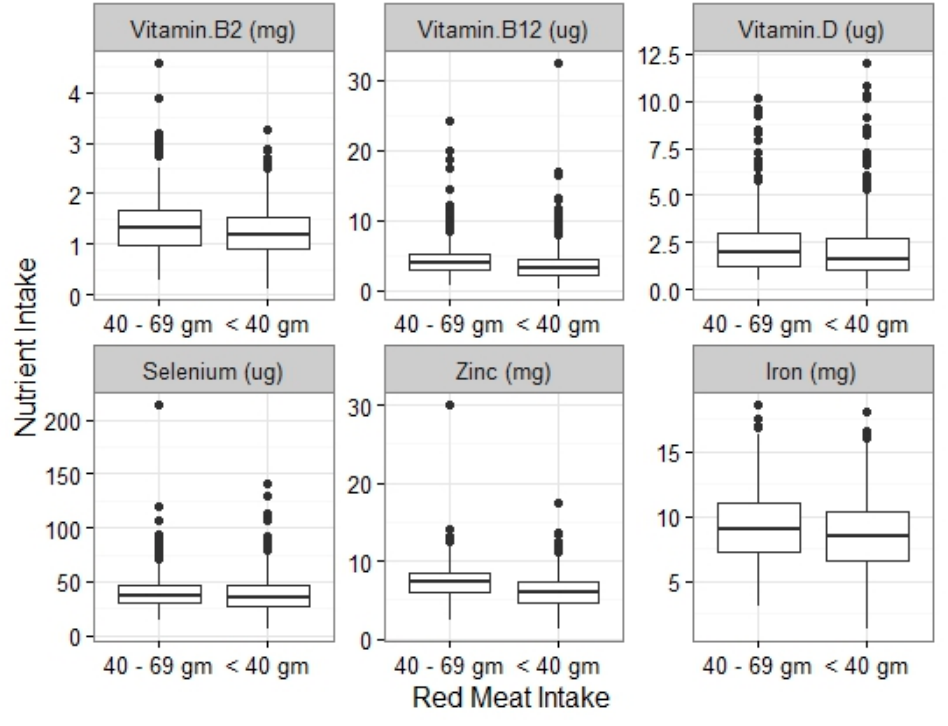
Figure 1. Associations between daily red meat intakes (higher and lower thresholds) and nutrient intakes.